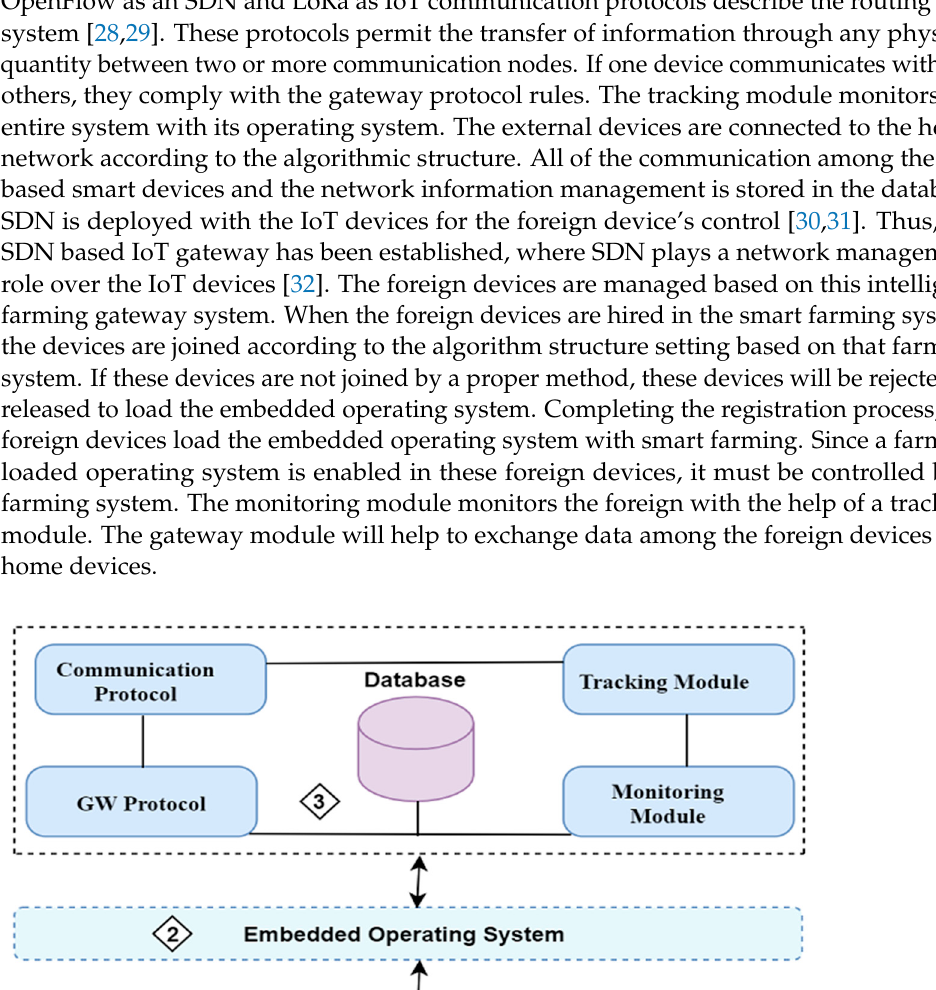
Algorithm 1: Proposed Foreign Agent Selection Algorithm